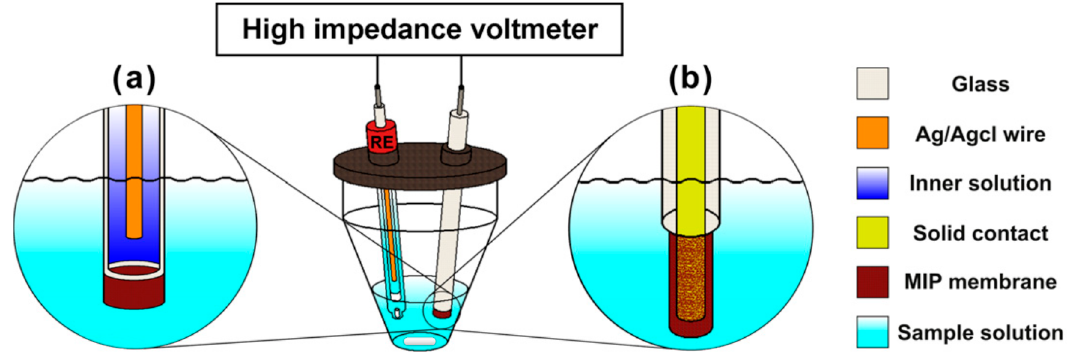
Figure 1. Typical setup for potentiometric measurements: with either an inner-reference ion-selective electrode (ISE) ( a ) or coated wire ISE ( b ) and a reference electrode (RE). Reprinted with permission from [27].